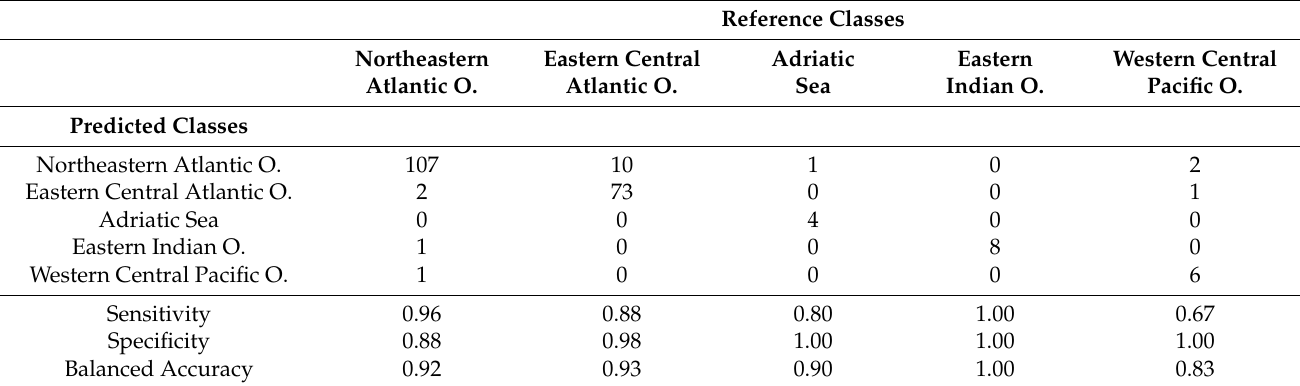
Table 2. Performance of classification of support vector machine model to discriminate cuttlefish according to the origin in hold-out validation.